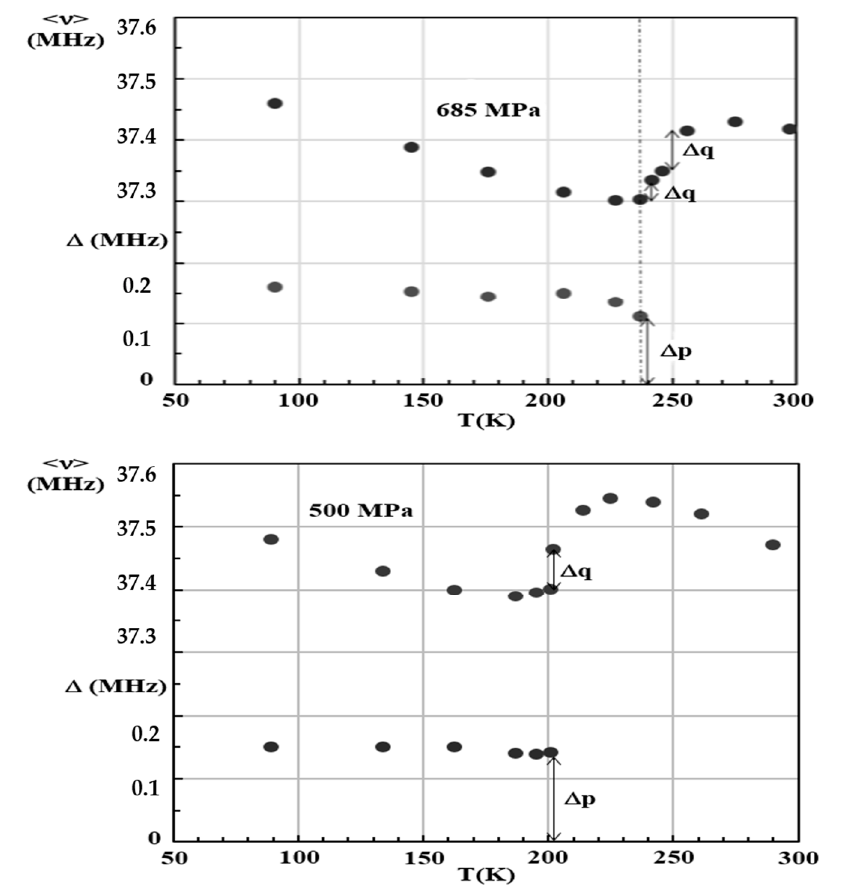
Figure 12. Temperature evolution of the (average) frequency and splitting for the high frequency NQR line at 500 MPa (bottom) and at 685 MPa (top). Adapted with permission from Reference [8]. Copyright 1997 American Physical Society.